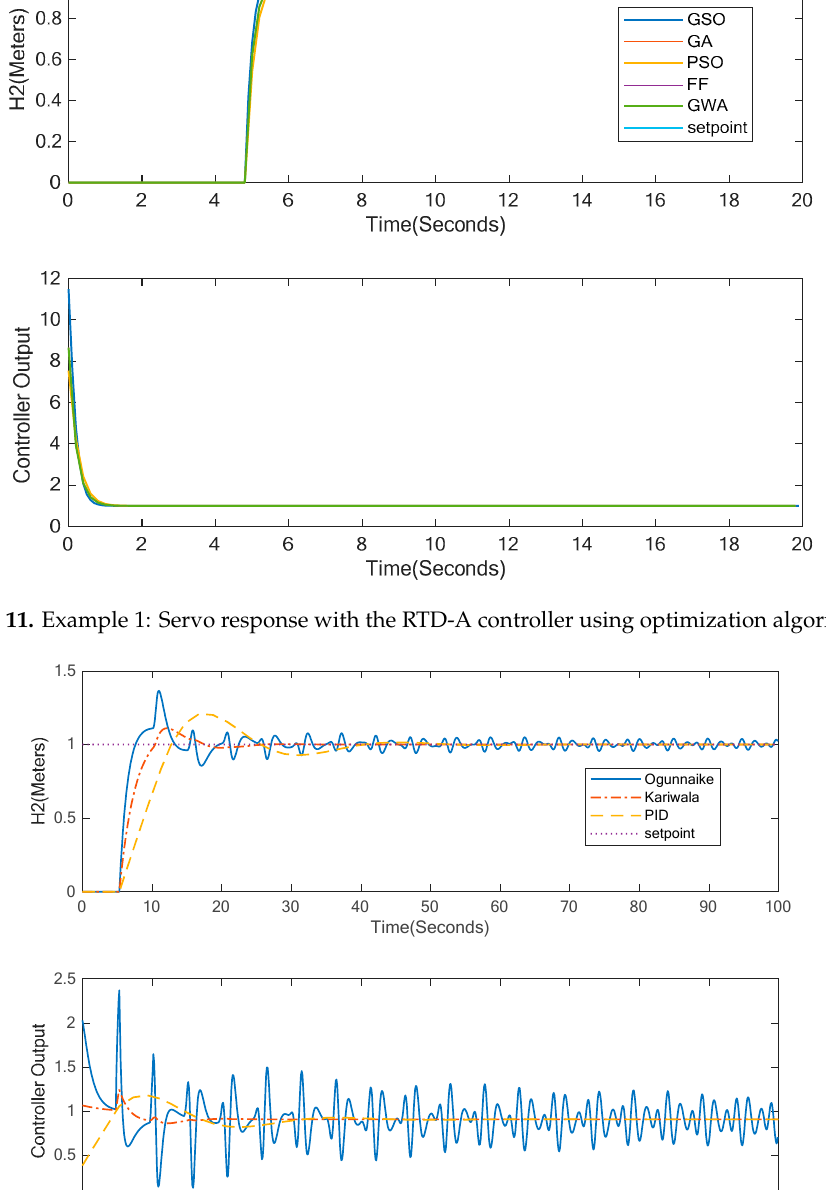
Figure 12. Example 1: Servo response with the RTD-A controller with disturbance and uncertainties.